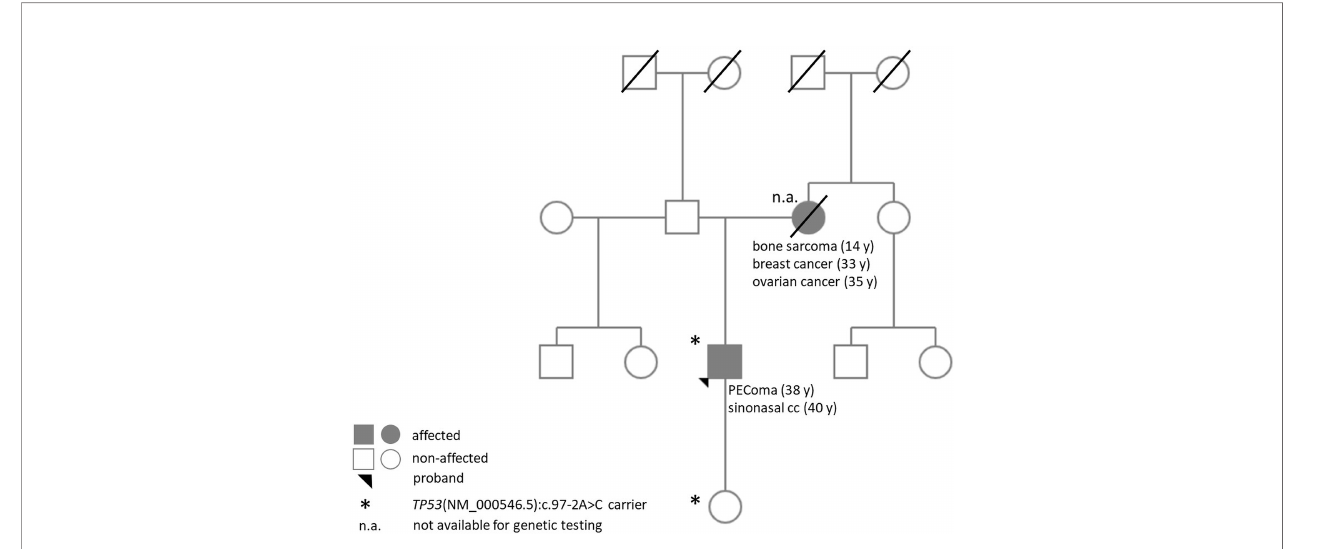
FIGURE 2 | Pedigree of the proband.